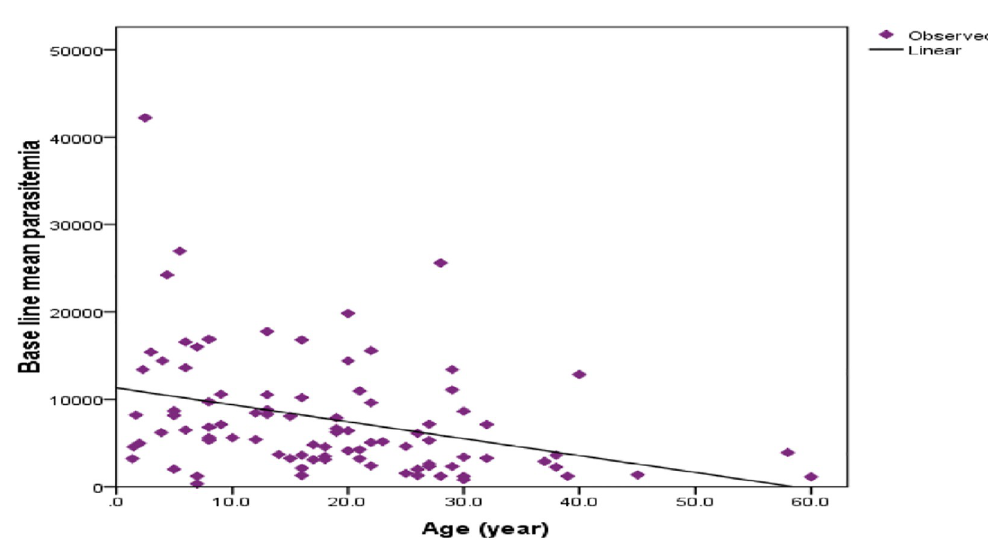
Fig 2. Relation between age and parasite counted at baseline of study participants in Shewa Robit Health Centre, northeast Ethiopia from November 2020 to March 2021.